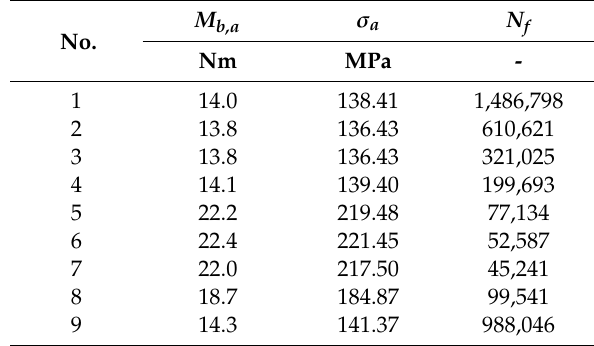
Table 7. Results of fatigue tests on samples after 14 days in a 3.5% NaCl solution in demineralised water.